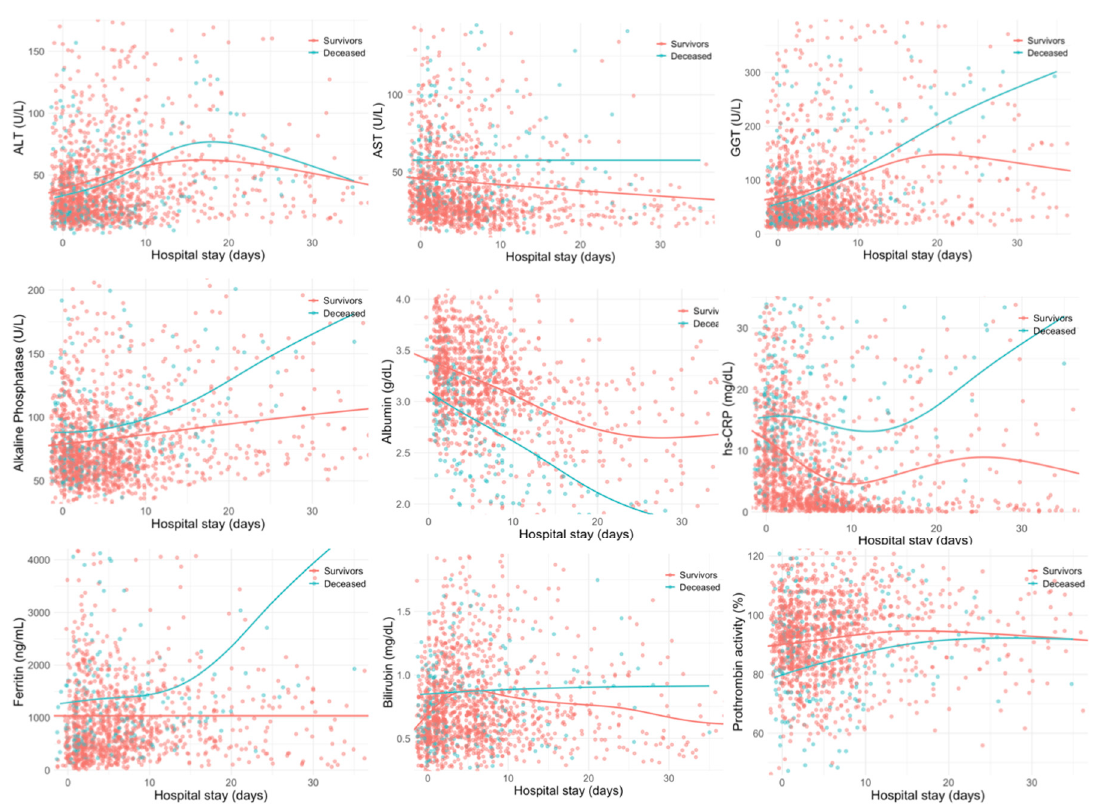
Figure 2. Longitudinal variations for each variable per category (survivors vs. deceased). Scatterplots represent data between the 2.5 and 97.5 percentiles. Each dot represents a single analysis during the first 5 weeks of hospitalization.